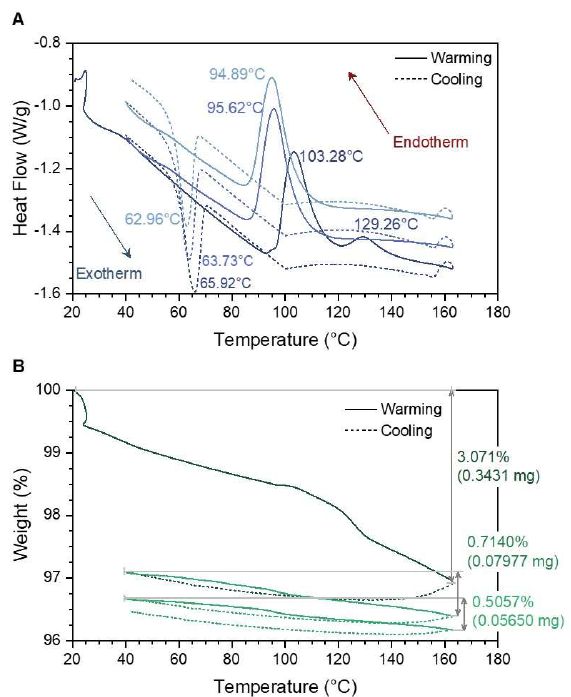
Figure 5. TGA and DSC data obtained for [Fe(Htrz) 2 (trz)](BF 4 )] as it was thermally cycled 3 times in an inert atmosphere. ( A ) DSC data on the phase changes as the sample is heated from room temperature to 160 °C for a total of 3 cycles. ( B ) TGA data on the weight changes that correspond to the 3 thermal cycles (marked 1, 2, and 3 next to heating and cooling transition temperatures). Thermal hysteresis can be seen in ( A ) between the exothermic (high to low spin state transition) and endothermic events (low to high spin transitions).